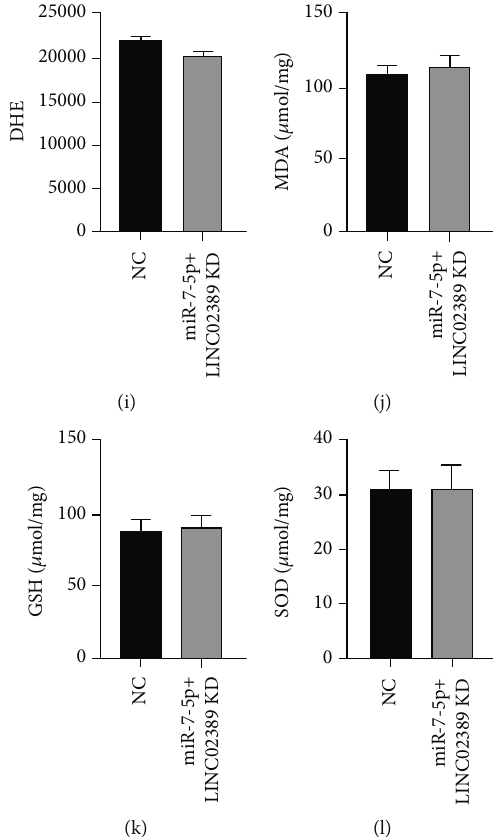
Figure 6: (a – d) DHE, MDA, GSH, and SOD expressions in A549-R compared with A549. (e – h) DHE, MDA, GSH, and SOD expressions in LINC02389 knocked down A549-R. (i – l) DHE, MDA, GSH, and SOD expressions in LINC02389 and miR-7-5p knocked down